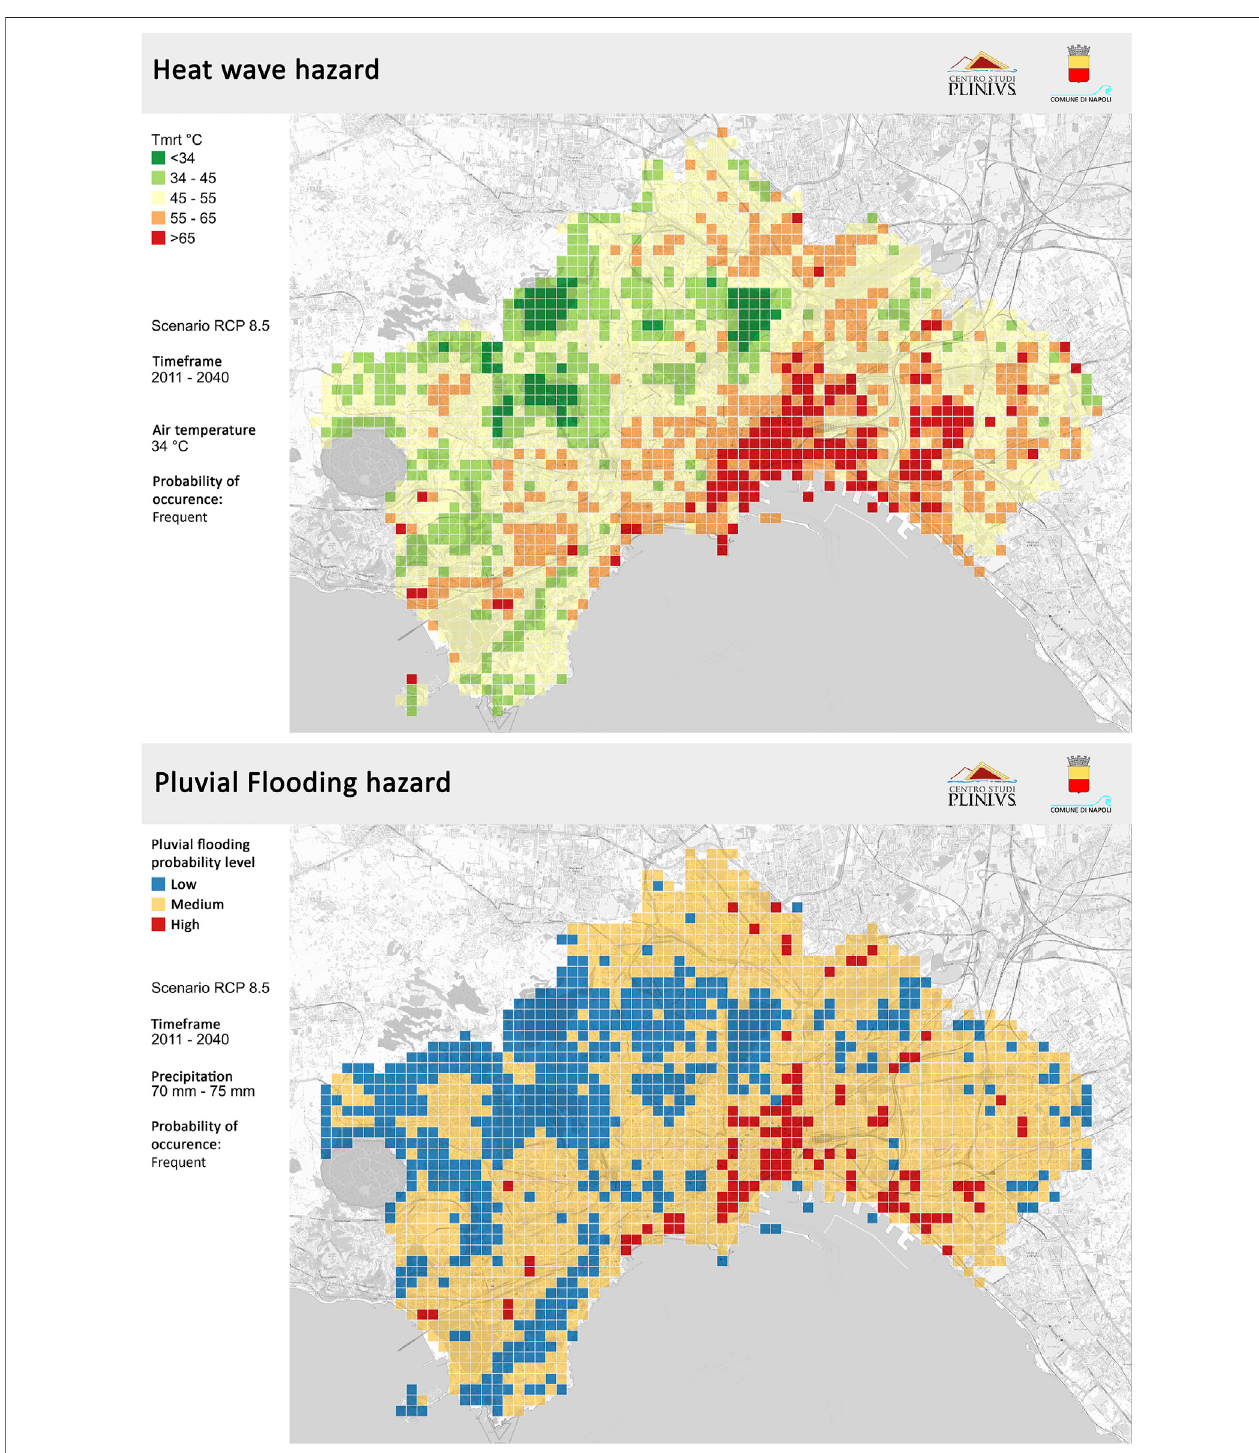
FIGURE 3 | Hazard local effect results for Naples municipality from HWLEM (top) and FLEM (bottom) , corresponding to a “ frequent ” event in the period 2011 – 2040, RCP 8.5.